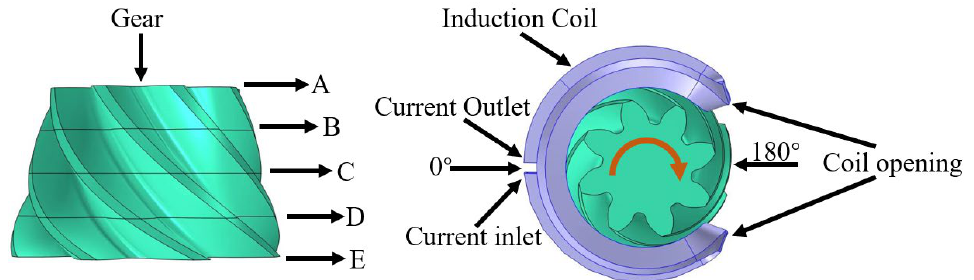
Figure 10. Selection of gear surface study curves.